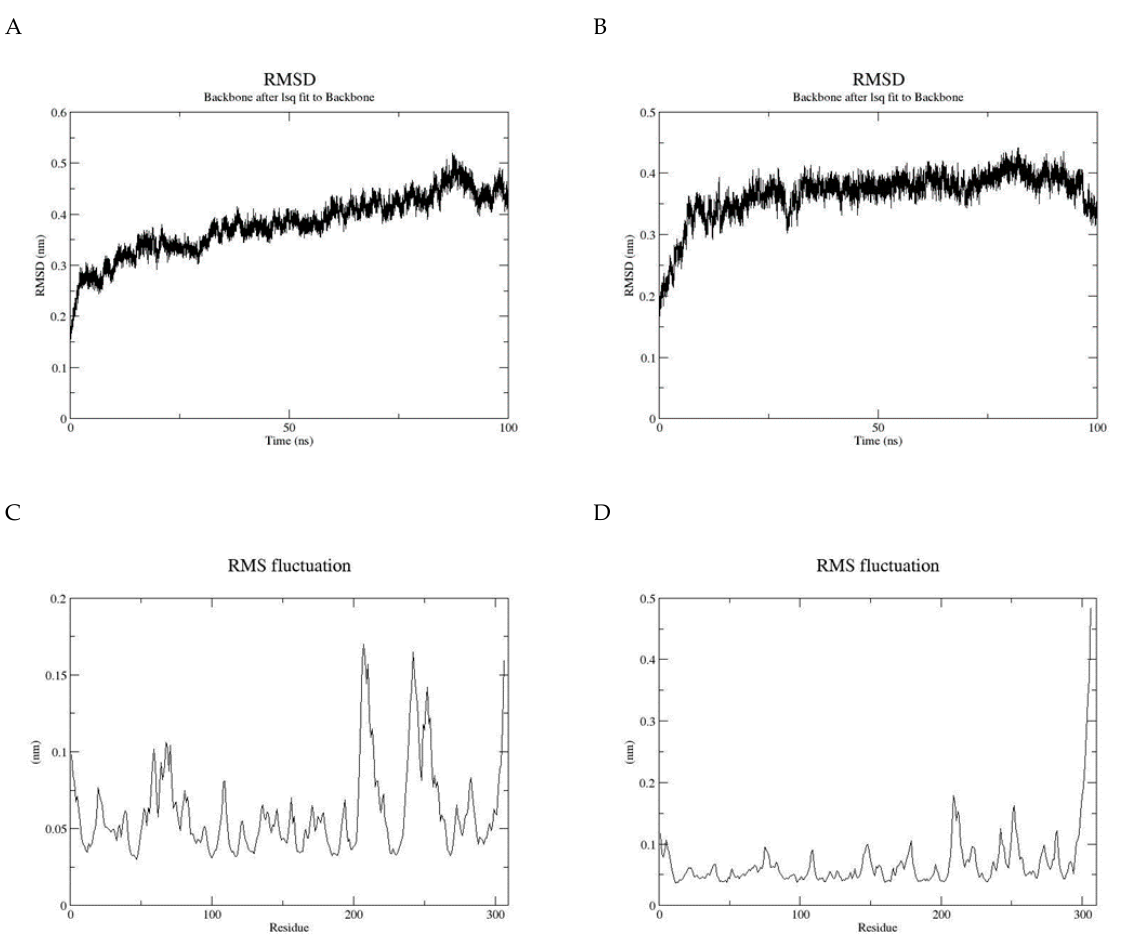
Figure 8. ( A ) Root-mean-square deviations (RMSDs) of C α atoms for two models, CHT and ( B ) mutant of CHT (mCHT), ( C ) root-mean-square fluctuations (RMSFs) of side chains for CHT model, and ( D ) root-mean-square fluctuations (RMSFs) of side chains for mCHT model.